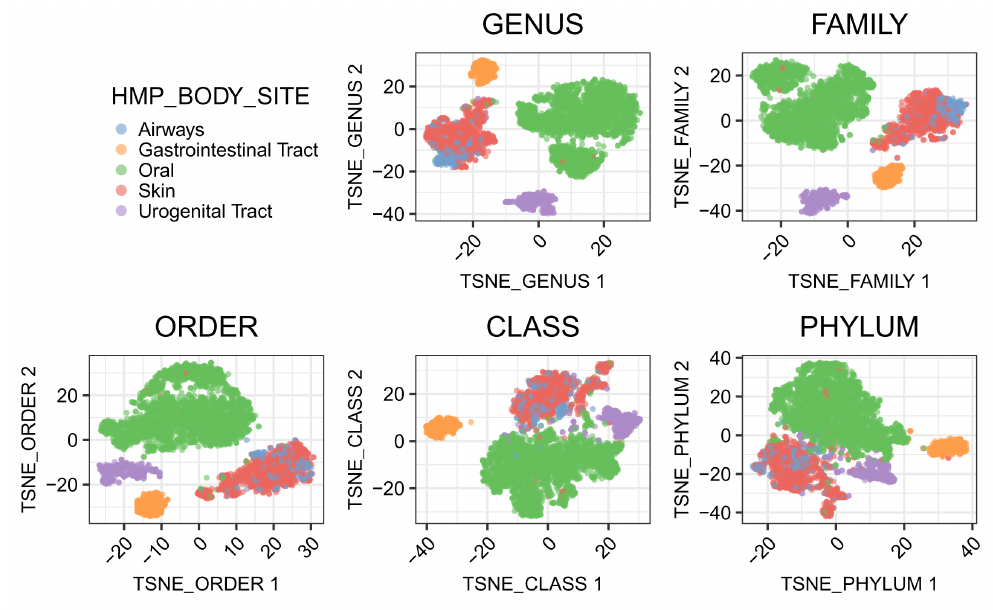
Figure 11. t-SNE plot of samples using data at different taxonomic levels. The two t-SNE components computed are plotted. Each point is a sample. Samples are colored according to the body sites.